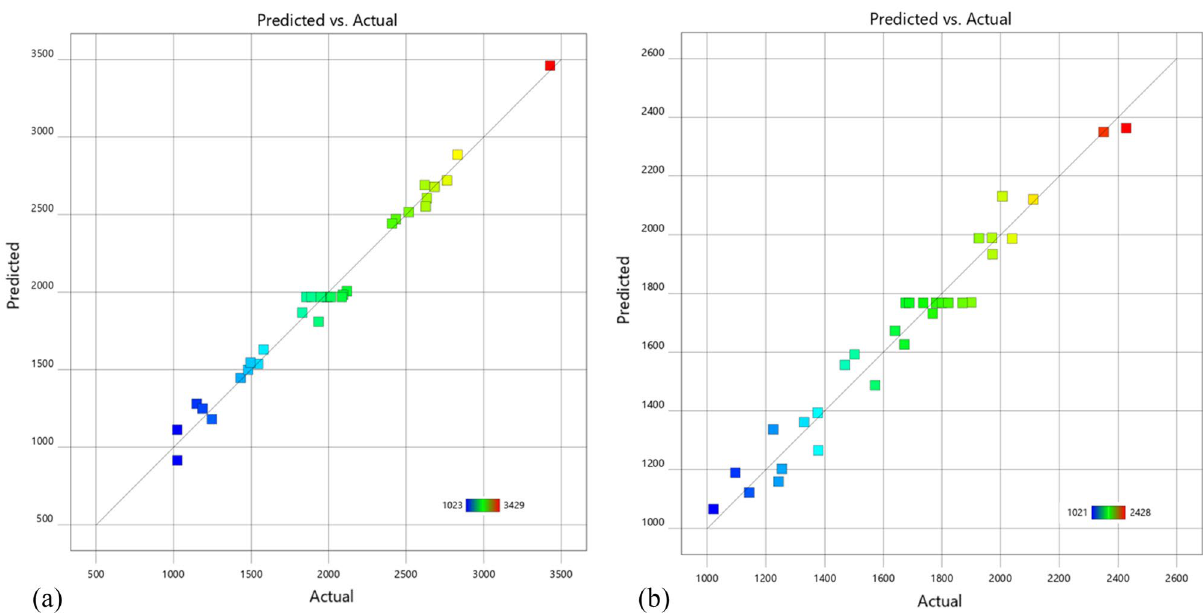
Figure 7. Scatter plot. ( a ) Scatter plot of actual and predicted distance of throwing-soil. ( b ) Scatter plot of actual and predicted efficiency of